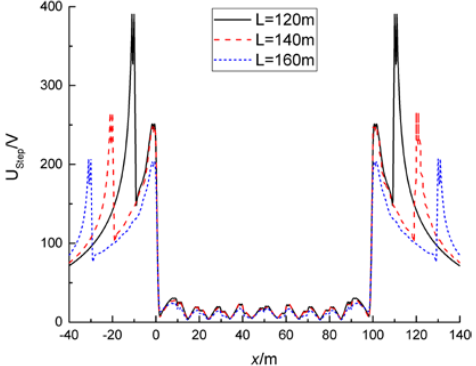
Figure 3. The change in step voltage with length L. Table 1. The maximum ground potential rise and the grounding resistance under different parameters of large backfill area.